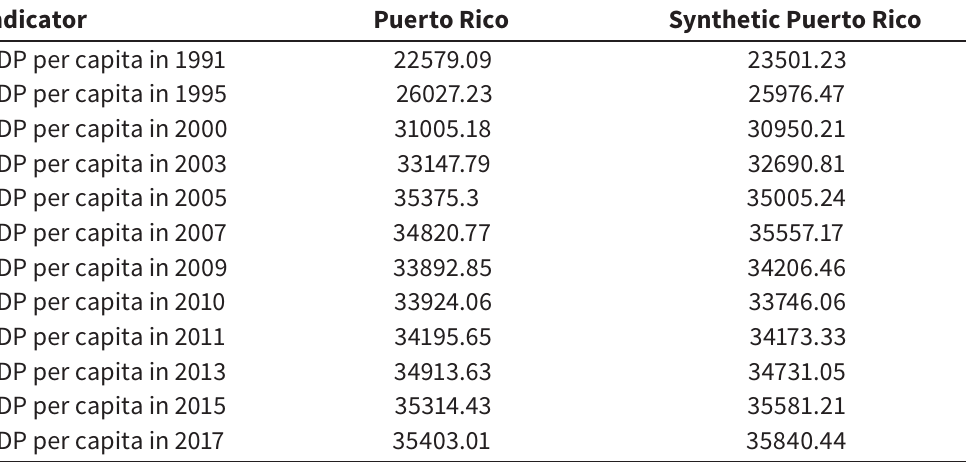
Indicators in Puerto Rico vs. Synthetic Puerto Rico (GDP Matching)